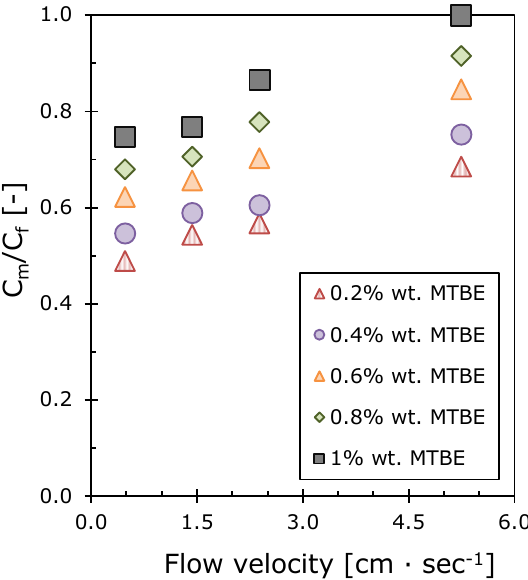
Figure 10. The dependences of the concentration polarization modulus on the feed flow velocity at various MTBE concentrations.